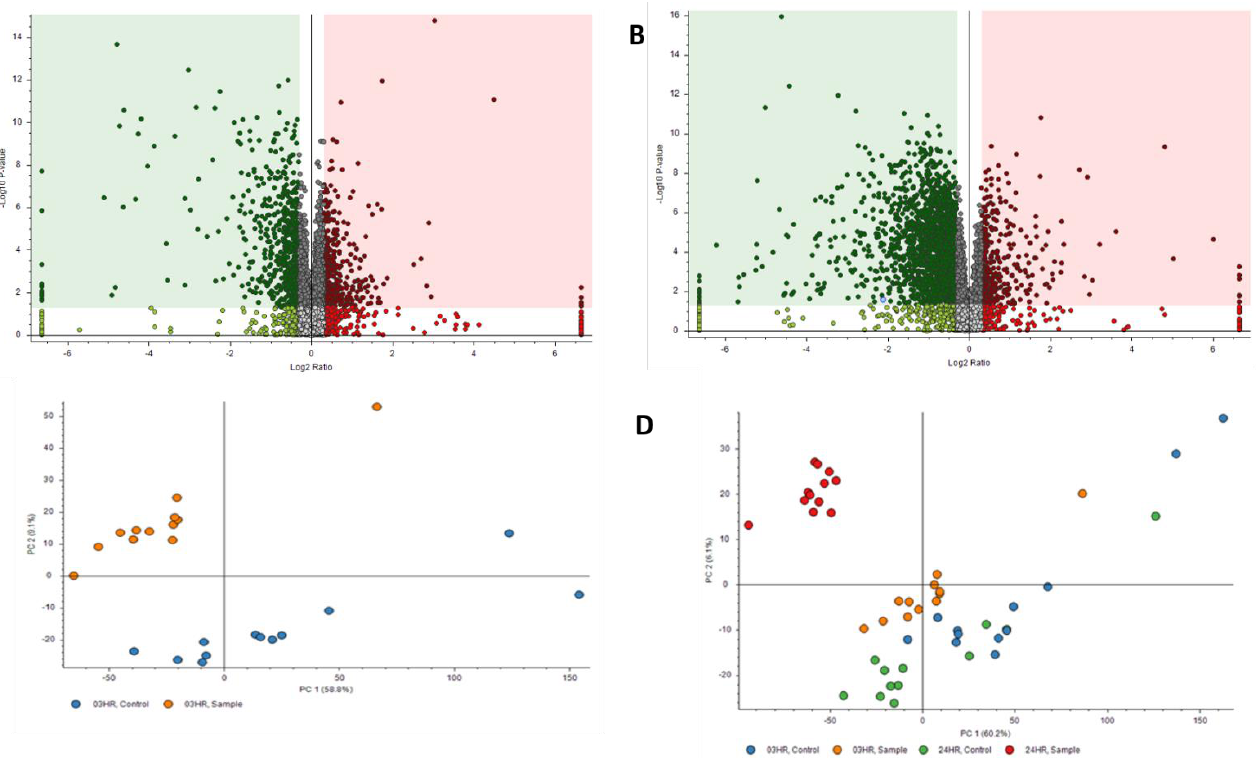
Figure 3. Volcano Plots of proteins at ( A ) 3 h post exposure and ( B ) 24 h post exposure. Principal component analysis (PCA) plots for ( C ) exposed and control samples at 3 h post exposure and ( D ) exposed and control samples at 24 h post exposure.